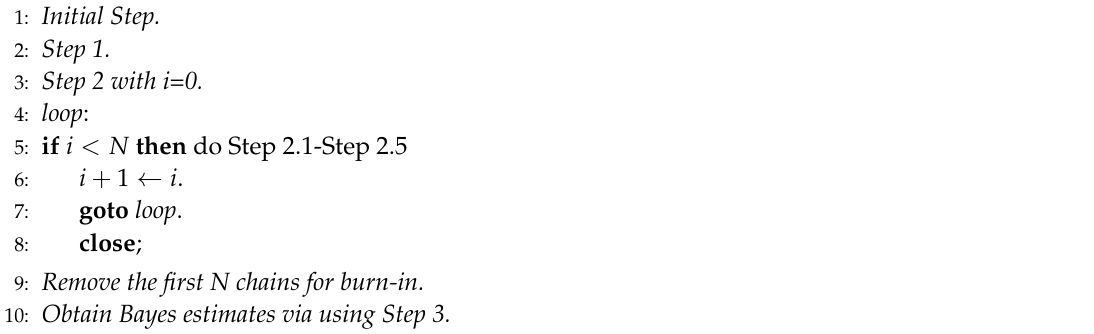
Algorithm 1 The Metropolis-Hastings algorithm via Gibbs